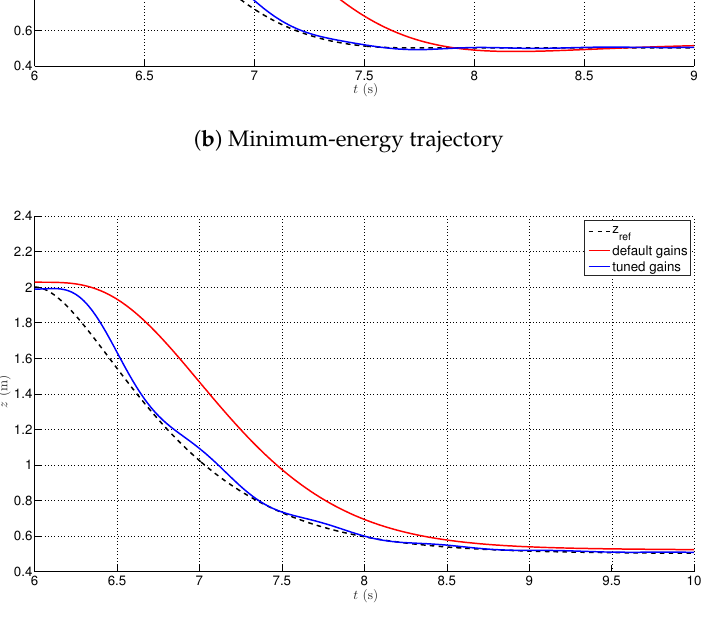
Figure 13. Comparison of behaviour of the model of the Parrot Rolling Spider in Matlab